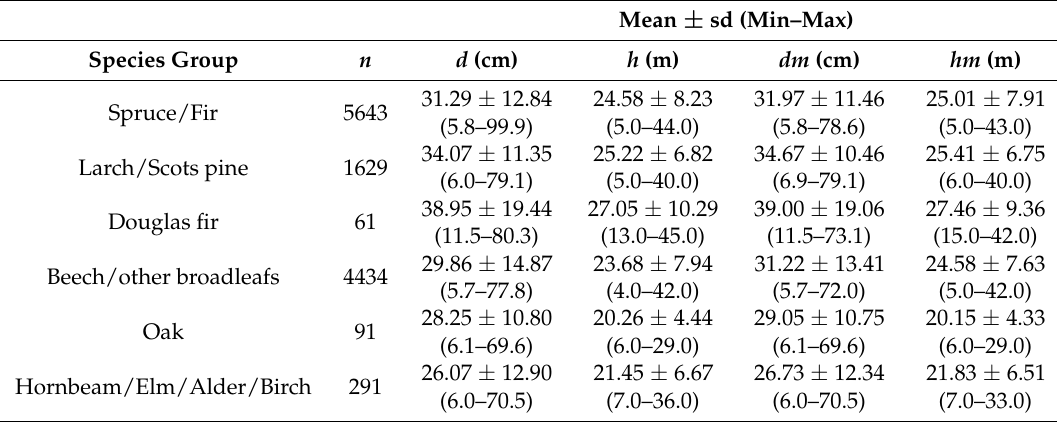
Table 4. Summary statistics of the model data with respect to species groups. d = diameter at breast height; h = height; dm = diameter of the median basal area tree; hm = height of the median basal area